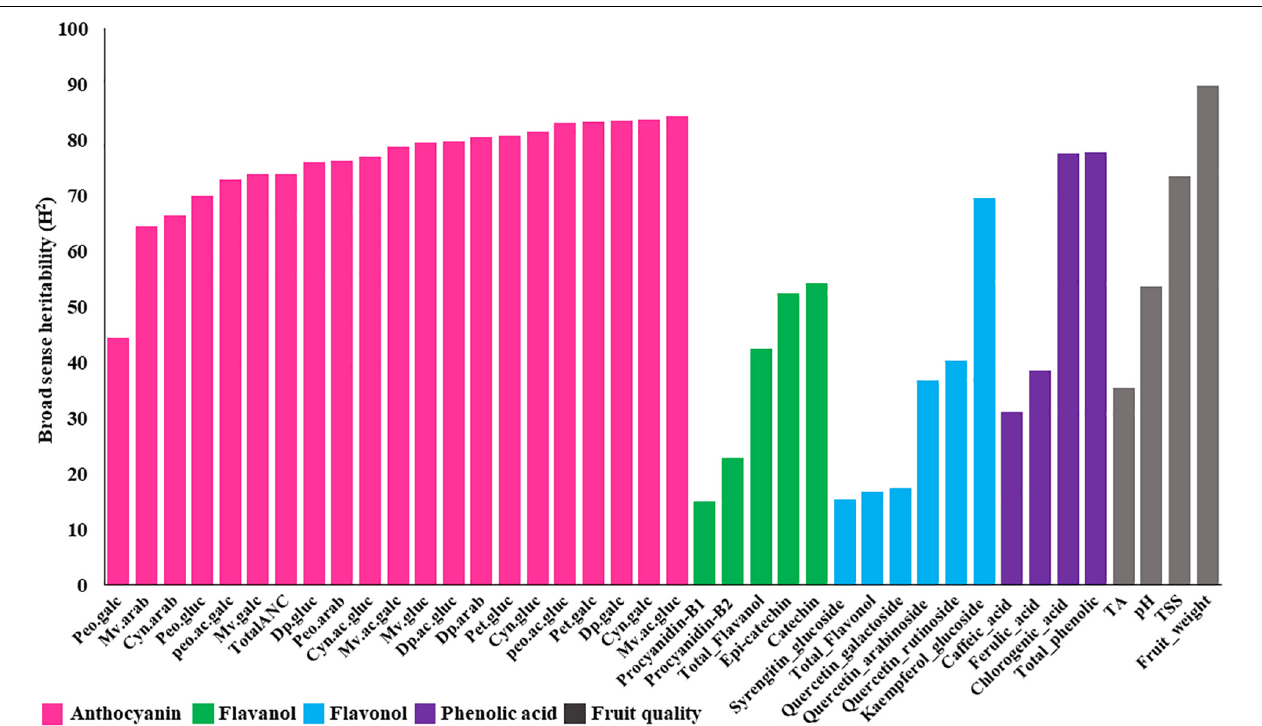
FIGURE 2 | Broad sense heritability estimates for metabolites and fruit quality traits across 100 tetraploid accessions over two years. Anthocyanin abbreviations: Dp, delphinidin; Cyn, cyanidin; Peo, peonidin; Mv, malvidin; Pet, petunidin; gluc, -3-glucoside; galc, -3-galactoside; arab, -3-arabinoside; ac.gluc, -3-(6-acetyl glucoside); ac.galc, -3-(6-acetyl